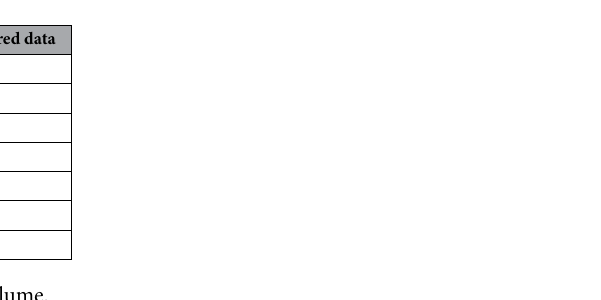
Table 7. Section classification and data